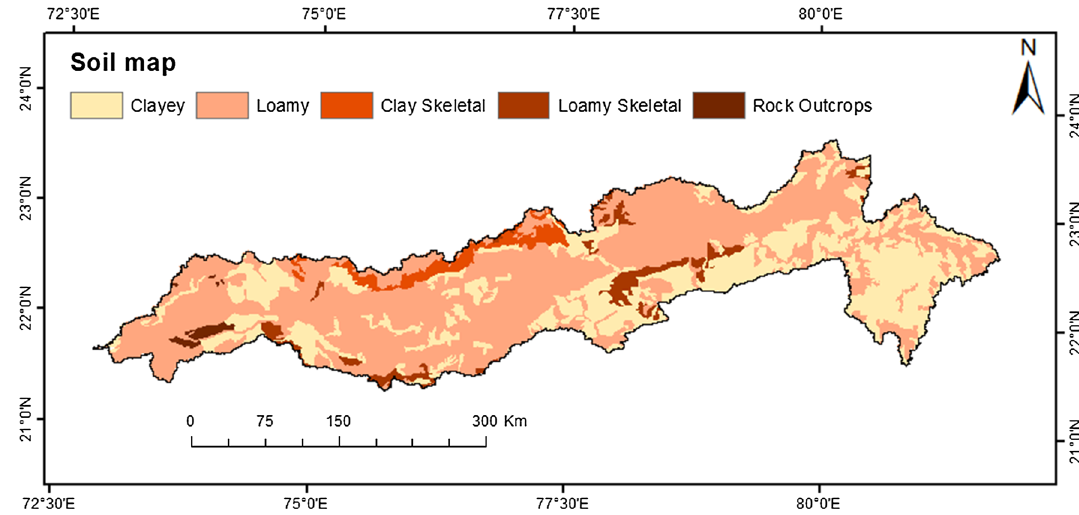
Fig. 8 Classified LULC map of Narmada River Basin